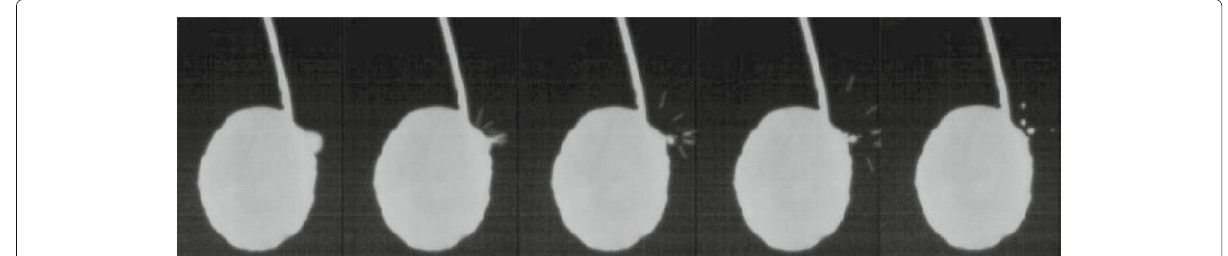
Fig. 15 High speed camera visions (1/5000 s apart) from left to right. Between the 4th and 5th frames, four frames are omitted. The sample charge ( ∼ CI-chondritic composition doped with 3 wt.% carbon) is suspended with a PtRh wire and is in its total melting at 1500 °C. The horizontal width of the charge is ∼ 5 mm. A bulged bubble on the 1st frame is already ruptured on the 2nd frame, where multiple film-droplets are ejected while a jet is still developing from the center of the collapsed cavity. On the 3rd and 4th frames, the six film-droplets are spreading out in concert, while the first jet-droplet is detached from tip of the jet. Skipping four frames, the 5th frame shows three jet-droplets moving away from the mother liquid body. Their direction of motion is up and far side of the picture. The film-droplets are out of the 5th frame because they move fast